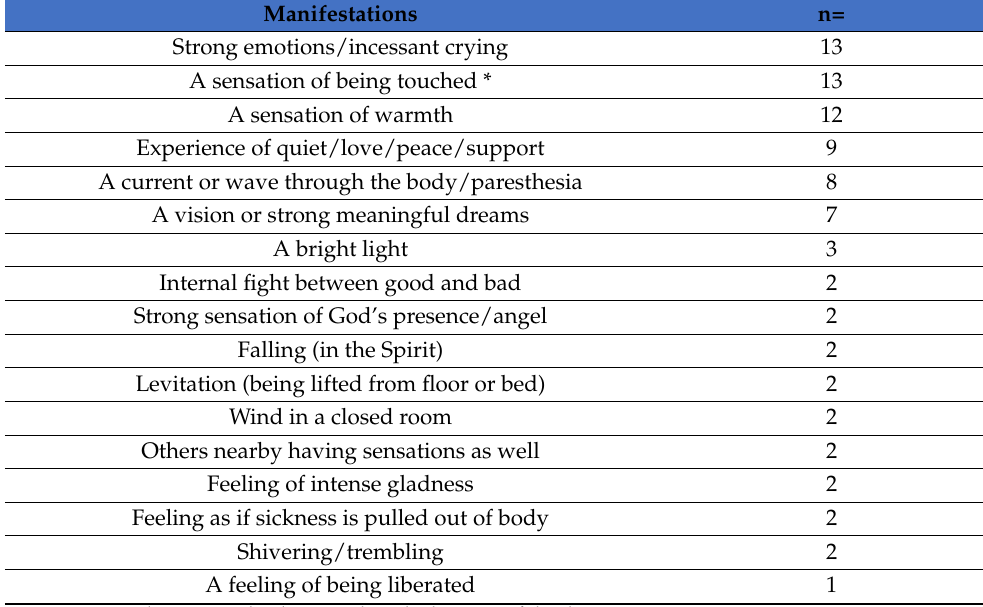
Table 10. Reported manifestations (physical, emotional, existential) accompanying all reported healing experiences.